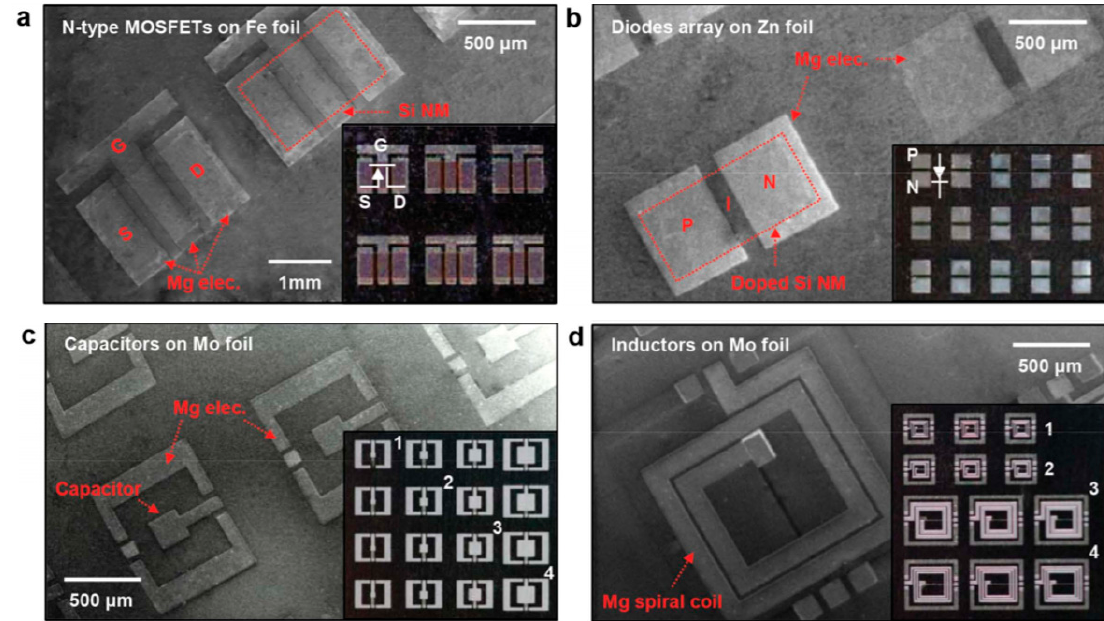
Figure 11. Scanning electron microscope (SEM) and optical microscope image (inset) of diverse transient devices on dissolvable metal foil substrates. ( a ) array of nMOSFETs on Fe foil. ( b ) Transient PN diode on a Zn foil. ( c ) Capacitors with different sizes built using Mg electrodes (top/bottom) and PECVD SiO 2 dielectrics on Mo foil. ( d ) Planar spiral coils on a Mo foil substrate. Adapted from [45] with permission. Copyright © 2015 Wiley and Sons.